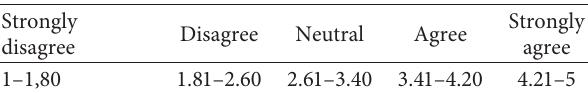
Table 6: The five-point Likert